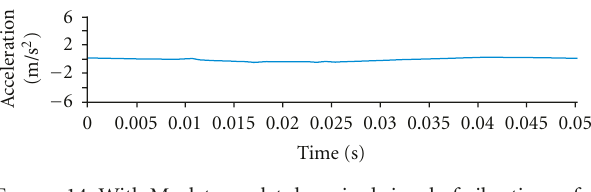
Figure 14: With Morlet wavelet de-noised signal of vibrations of a faultless gear unit.